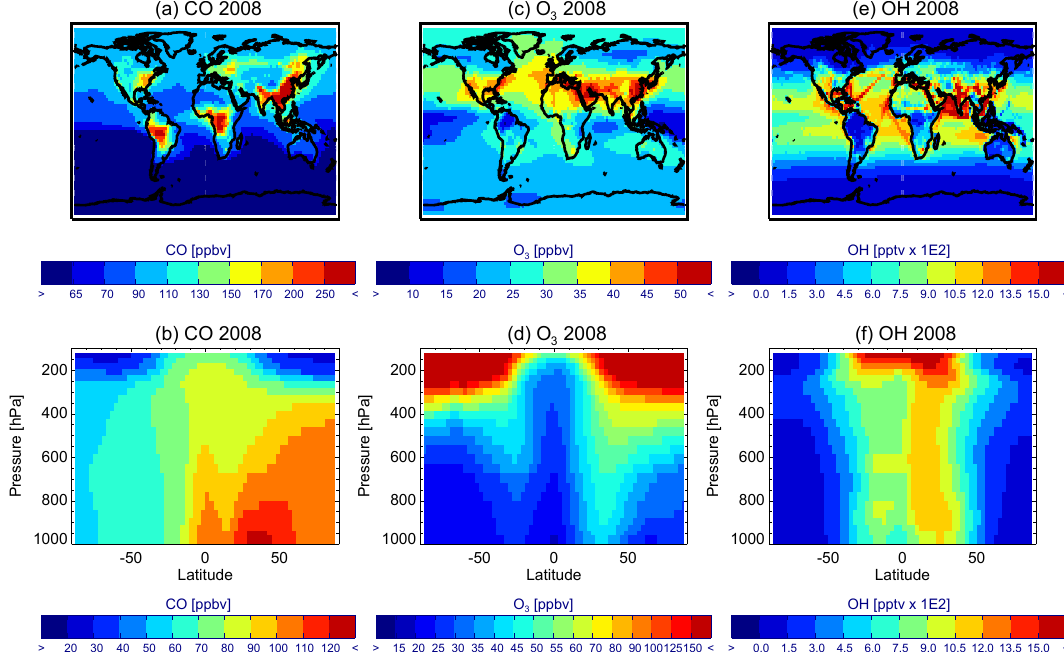
Figure 3. Concentrations of TOMCAT-simulated annual surface mean and annual zonal mean CO (a, b) , O 3 (c, d) and OH (e, f) .